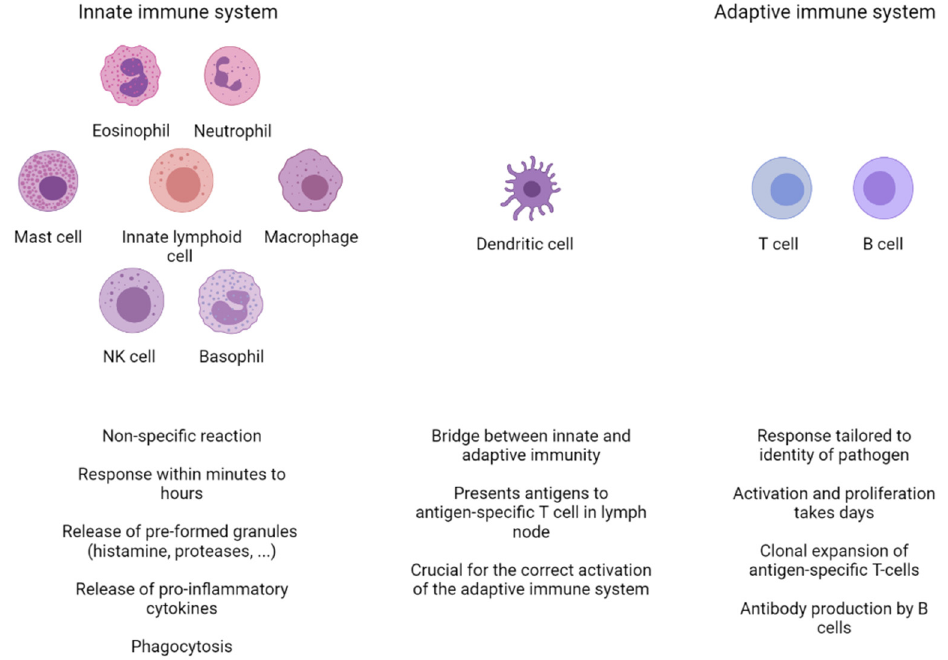
Figure 1. Overview of the different cell types of the innate and adaptive immune systems. The innate immune system is the first line of defense. It consists of eosinophils, neutrophils, macrophages, basophils, natural killer (NK) cells, mast cells, and innate lymphoid cells. They are capable of responding within minutes to foreign pathogens through a variety of non-specific mechanisms, including the release of granules and pro-inflammatory cytokines. In some cases, this initial response is followed by a reaction from the adaptive immune system, consisting of T and B cells. The adaptive immune response takes longer to develop and is crucially dependent on dendritic cells (DCs). DCs patrol their microenvironment, take up and process antigen material, and present it to T cells in the local lymph node. This results in the clonal expansion of an antigen-specific T cells, which will recirculate to the site of infection and help clear up the infection. Activated B cells will proliferate and differentiate into antibody-secreting plasma cells.